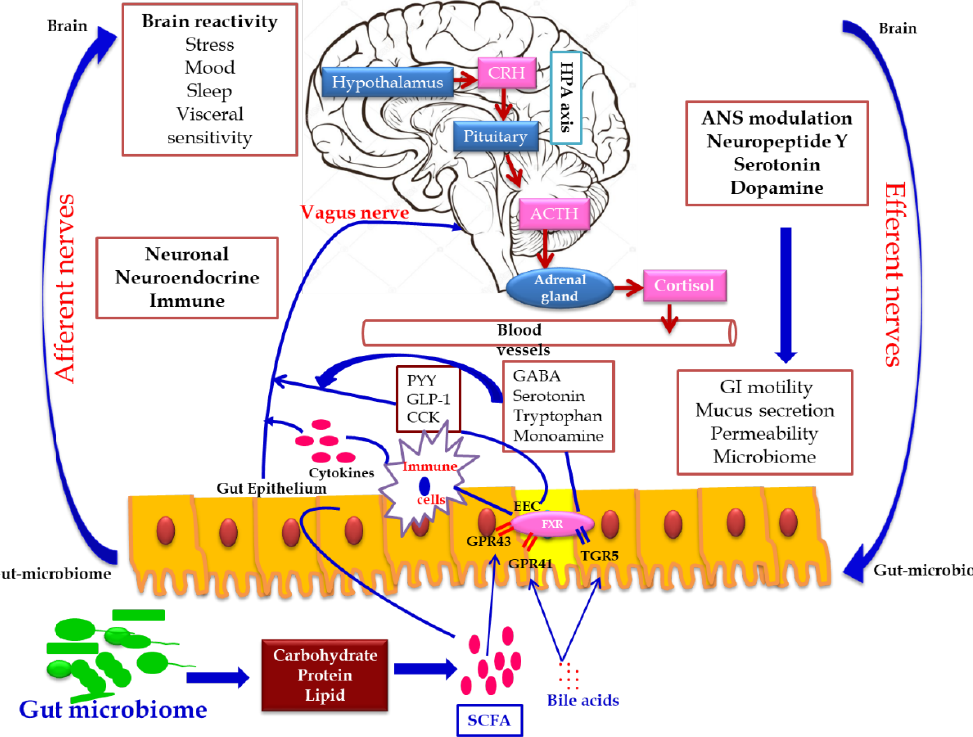
Figure 2. Gut microbiome–brain axis: bidirectional signaling pathways illustrating the relationship between the gut microbiome, intestinal barrier and the brain. Gut microbiota communicates with the brain through the neuro–endocrine–immune network either indirectly via the gut-derived molecules acting on afferent vagal nerve endings, or directly via the microbe-generated signals. The brain’s structural connections (the multiple interconnected structural networks of the central nervous system) regulates the gut microbiota via the autonomic nervous system. Disturbance in the bidirectional interaction response gain is due to psychosocial or gut-derived stress manifests to brain–gut disorders.